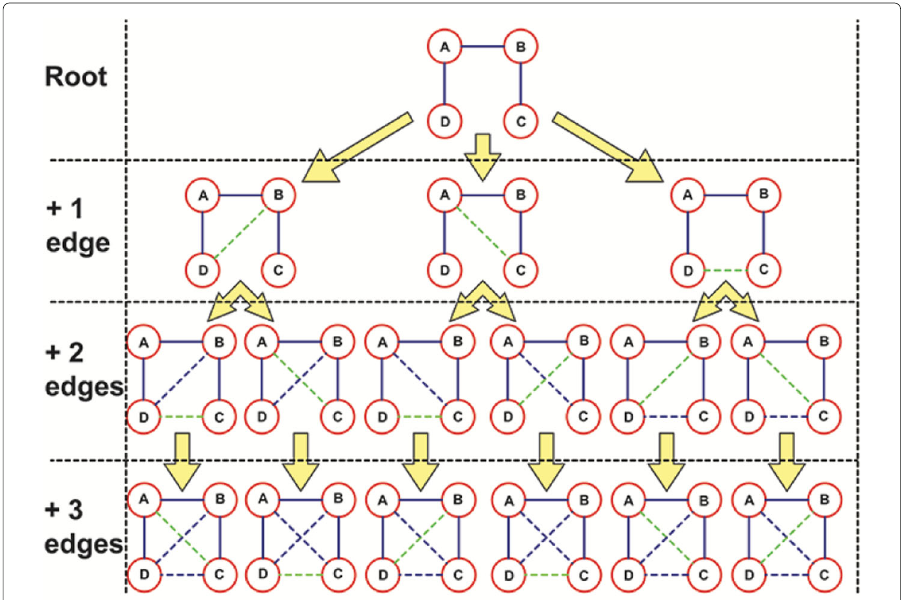
Fig. 5 The AS of the 4-nodes path. The root is the 4-nodes path. Inner vertices of the AS store all subgraphs that can be obtained from the 4-nodes path by inserting 1,2 or 3 edges. Dashed green edges are the newly added one, while dashed blue edges are those that have been previously added